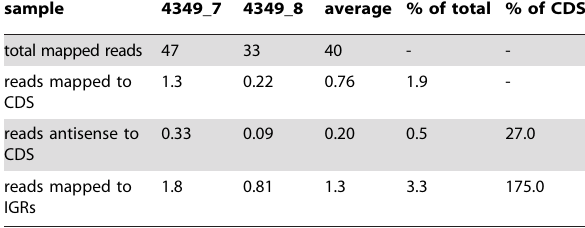
Table 2. RNA sequencing profiles for stationary phase cultures of M. tuberculosis.